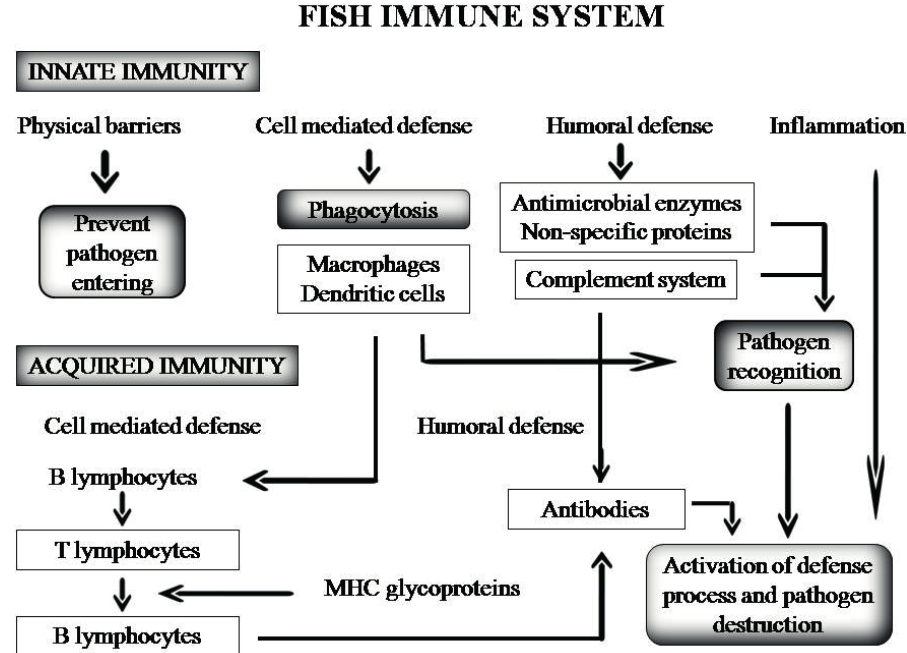
Figure 2 - The concept of fish immune system (Biller-Takahashi and Urbinati